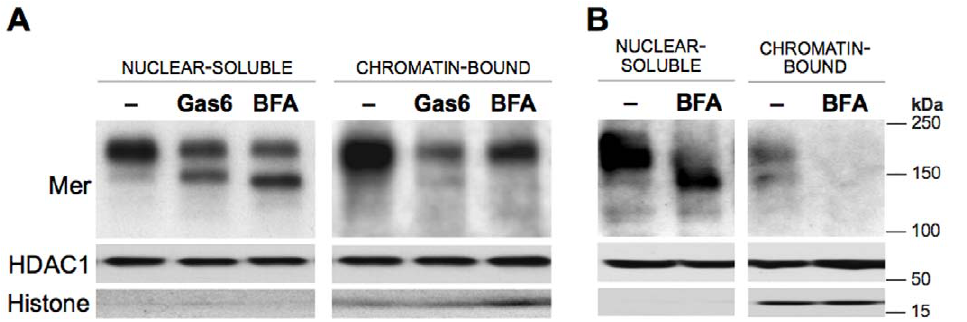
Figure 6. Nuclear compartments display preferential expression of different Mer glycoforms. Jurkat cells were cultured in the presence of 200 nM Gas6, 5 m g/ml BFA, or control ( 2 ) for the indicated times. Western blot detection of Mer in the nuclear-soluble and chromatin-bound fractions ( A ) collected after a 4-hour exposure, and ( B ) following a 24-hour treatment with BFA or control. Blots were also probed for HDAC1 and Histone H3 to ensure proper fractionation.